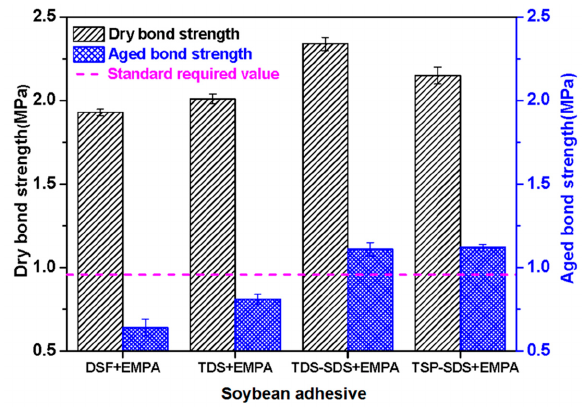
Figure 1. Bond properties of defatted soybean flour (DSF)-and soybean protein isolate (SPI)-based adhesives with various formulations.